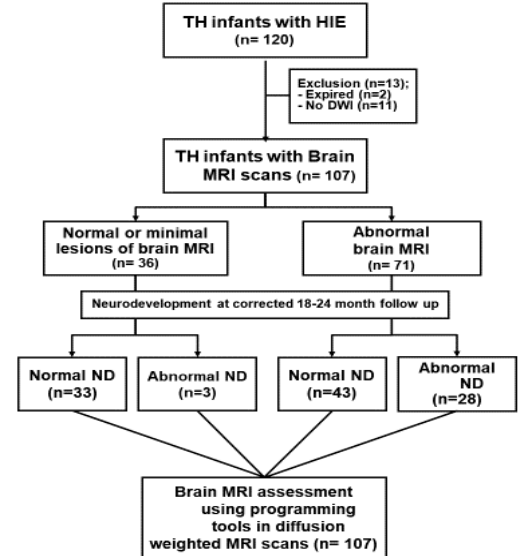
Figure 1. Flow chart of study. Abbreviations: TH, therapeutic hypothermia; HIE, hypoxic–ischemic encephalopathy; MRI, magnetic resonance imaging; ND; neurodevelopment, AI; artificial